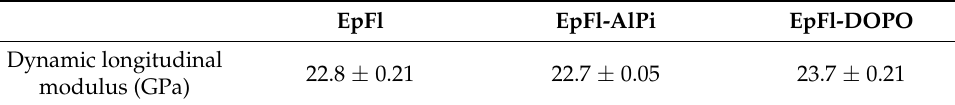
Table 2. Dynamic longitudinal modulus of unaged